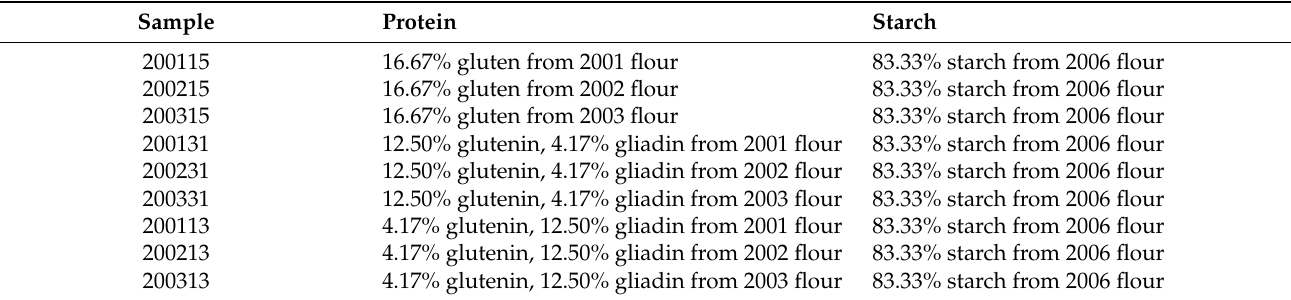
Table 1. The formulation of each recombinant